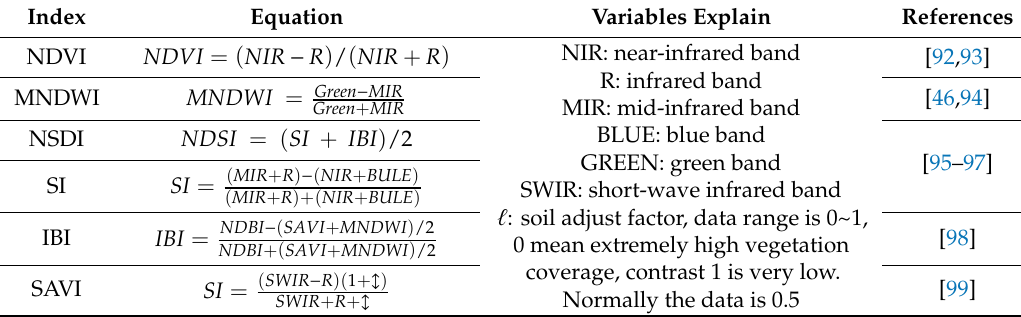
Figure 3. The technical framework. Table 2. The indices and